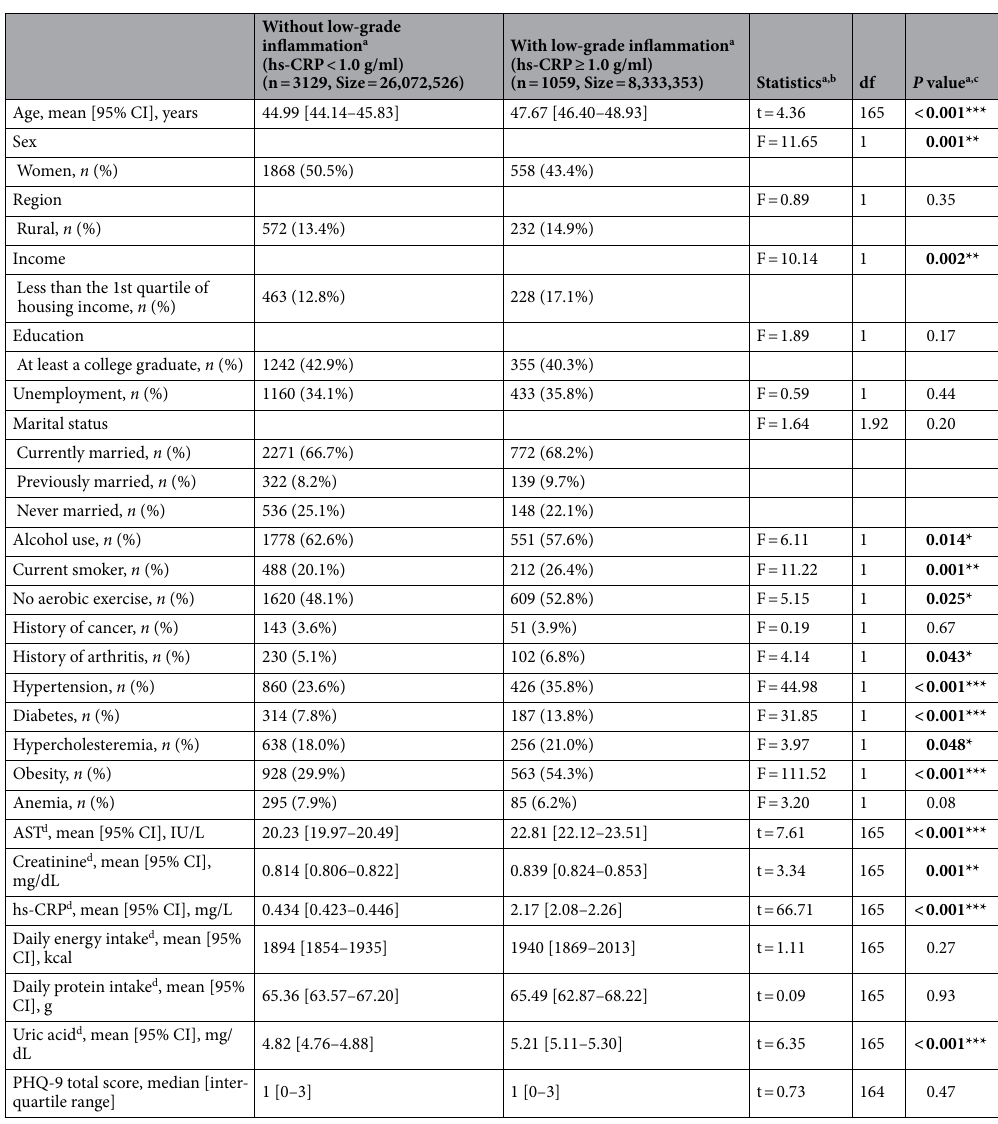
Table 1. Demographic and clinical characteristics of the study subjects stratified by low-grade inflammation status. hs-CRP = high-sensitive C-reactive protein, df = degree of freedom, CI = confidence interval, AST = aspartate aminotransferase, PHQ-9 = Patient Health Questionnaire-9. a Statistics adjusted for complex sample design. b Categorical variables based on the adjusted-F by Pearson’s chi-square tests, continuous variables except the PHQ-9 scores based on the t tests, and the PHQ-9 scores based on the design-based Kruskal Wallis tests. c p values are significant at α = 0.05 (*), 0.01 (**), and 0.001(***). d Due to the skewed distribution, logarithmic transformation was performed for the statistics, and the CIs were